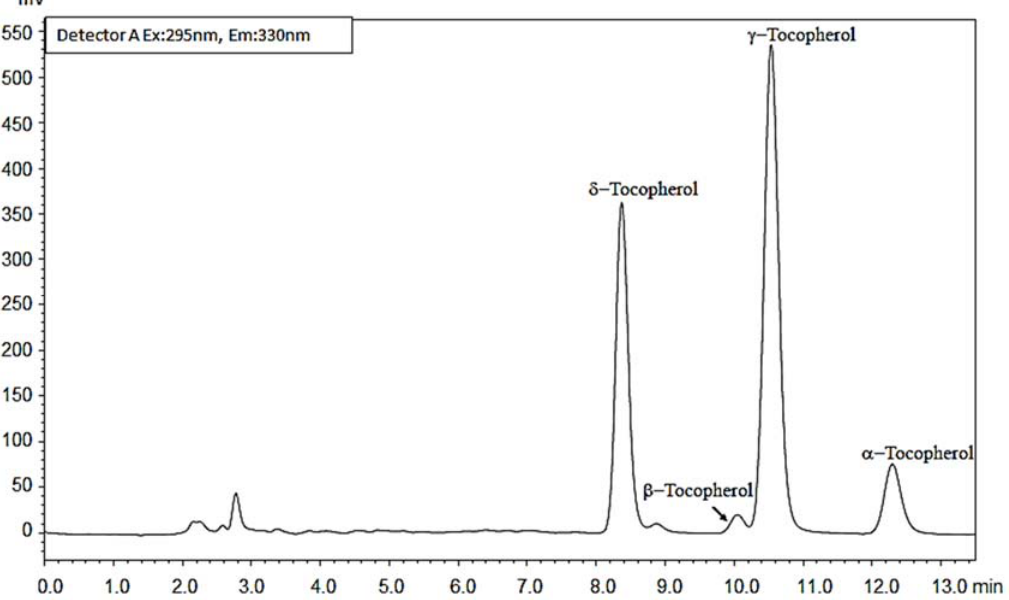
Figure 2. RP-HPLC/FLD chromatogram of tocopherols from Malus “Ola” oil separated using a Luna PFP column.